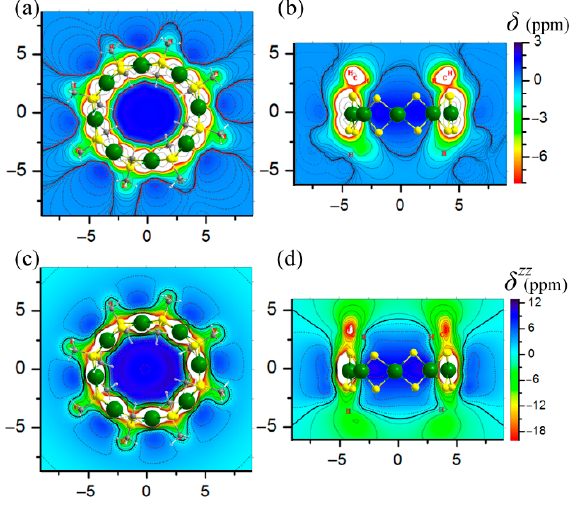
Figure 3. NICS maps δ ( r ) ( a , b ) and its ZZ component δ zz ( r ) ( c , d ) denoting shielded (negative values) and deshielded (positive values) areas in ppm for Pd 8 (SCH 3 ) 16 in perpendicular and parallel to Pd 8 ring ( xy and xz contour-plane) representations. The wider CS signal of CH 2 Cl 2 in the mixture solution was caused by CH 2 Cl 2 encap- sulated by Pd 8 (PET) 16 as well. As we know, in NMR spectrum, the total observed width of the absorption line ( Δ ν ) is used to define an effective relaxation time ( T ) by means of the relation ∆ ν ≈ T − 1 where the T is mainly determined by the spin-spin relaxation time ( T 2 ). When low concen- tration CH 2 Cl 2 was dissolved in CDCl 3 , the CH 2 Cl 2 could effectively produce spin-lattice relaxation due to its non-restricted thermal motion but generate a slow spin-spin relaxation process because CH 2 Cl 2 was mainly surrounded by CDCl 3 ; the long distance between the two H nuclei would cause a low probability of transverse relaxation. Once a CH 2 Cl 2 was encapsulated into the cavity of the Pd 8 S 16 framework, its spin-lattice relaxation became more difficult due to its restricted thermal motion, but its spin-spin relaxation became faster (a shorter T 2 ) because of the fixed relative position between CH 2 Cl 2 and Pd 8 (PET) 16